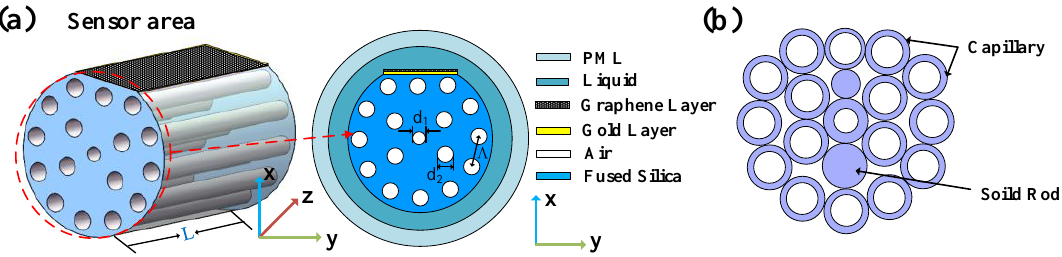
Figure 2. ( a ) Two-dimensional cross-section of the three-dimensional structure of the designed D-type PCF sensor ( Λ = 1.8 μ m, d = 0.4 Λ , t g = 40 nm, and L G = 3). ( b ) Stacked design of the PCF.